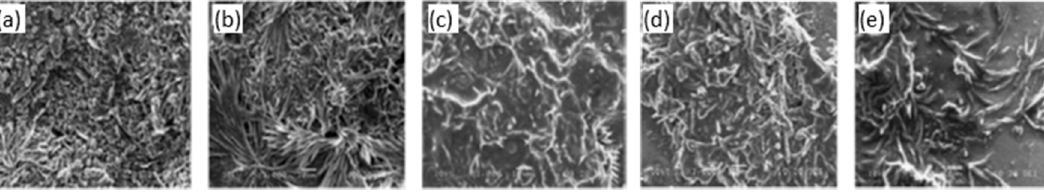
Figure 18. SEM images from cobaltous—polyaniline coatings with different thickness: ( a ) 10.38 μ m, ( b ) 17.26 μ m, 21.08 μ m ( c ), 23.57 μ m ( d ), and ( e ) 26.03 μ m. It can be appreciated in the first images (a and b) that the morphology is more porous that for the last ones ( d , e ). Reprinted from (Vijayan et al., 2008) with permission of Elsevier.